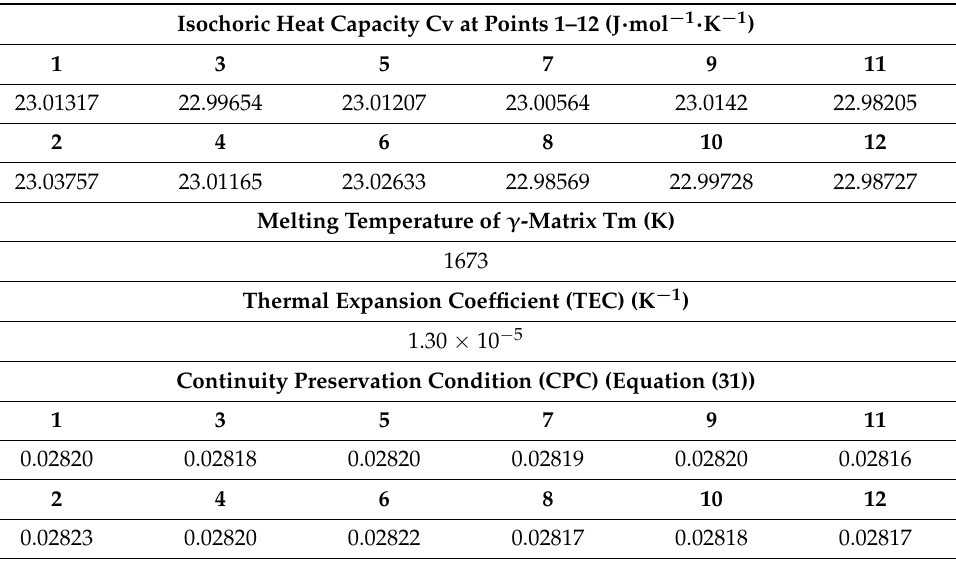
Table 6. Thermodynamic properties and CIC calculations at media points (Figure